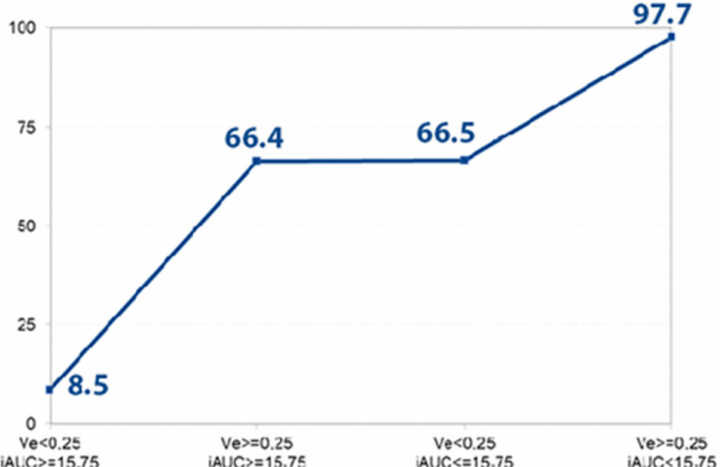
Figure 4. Disclosed probability for the PDAC. The graph shows the prognosticated probability of PDAC (%) (determined by logistic regression analysis) if the Ve and iAUC parameters or both of them exceed the defined cut-off value (Ve > 0.25, iAUC < 15.75). If both parameters are less than the determined cut-off point, the prognosticated probability for the presence of PDAC is 8.5%; if both values achieve the defined cut-off point, the estimated probability for the existence of PDAC is 97.7%. 3.4. Well-/Moderately Differentiated (G1/G2) PDAC vs. Poorly Differentiated (G3) PDAC There were 10 (35.7%) subjects with well-/moderately (G1 + G2), and 18 (64.3%) with poorly differentiated (G3) tumors. Analysis revealed that K trans , k ep , and iAUC were lower in poorly differentiated PDAC, whereas Ve showed no differences in G1 + G2 and G3 PDAC. The distribution between perfusion parameters is presented in Table